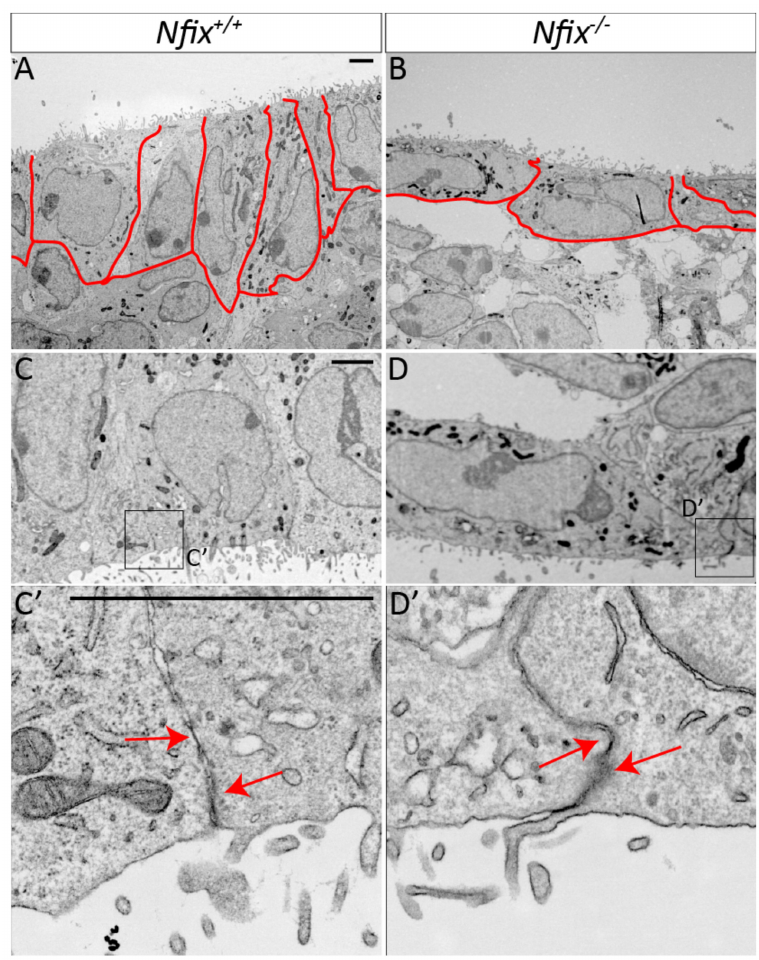
Figure 2. TEM of Nfix − / − ependymal cells reveal abnormal ependymal cell morphology. ( A , B ) Overviews of P5 Nfix +/+ ( A ) and Nfix − / − ( B ) lateral ventricles depict ependymal cells lining the surface of the ventricles. ( A ) P5 Nfix +/+ ependymal cells are shown to have a columnar appearance outlined in red. ( B ) In contrast to the columnar appearance of controls, Nfix − / − ependymal cells have a rounded appearance as outlined in red. ( C , D ) Images depicting a low magnification view of P5 Nfix +/+ ( C ) or Nfix − / − ( D ) ependymal cells including one or more ependymal cell-to-cell junction. ( C’ , D’ ) Images contained in boxes ( C’ , D’ ) are enlarged and displayed at higher magnification in panels ( C’ , D’ ). Red arrows highlight the cell junction. P5 Nfix − / − ependymal cells demonstrated reduced protein density along the cell junctions of adjacent ependymal cells compared to controls. Scale bars ( A , C , C’ ) represents 2 µ